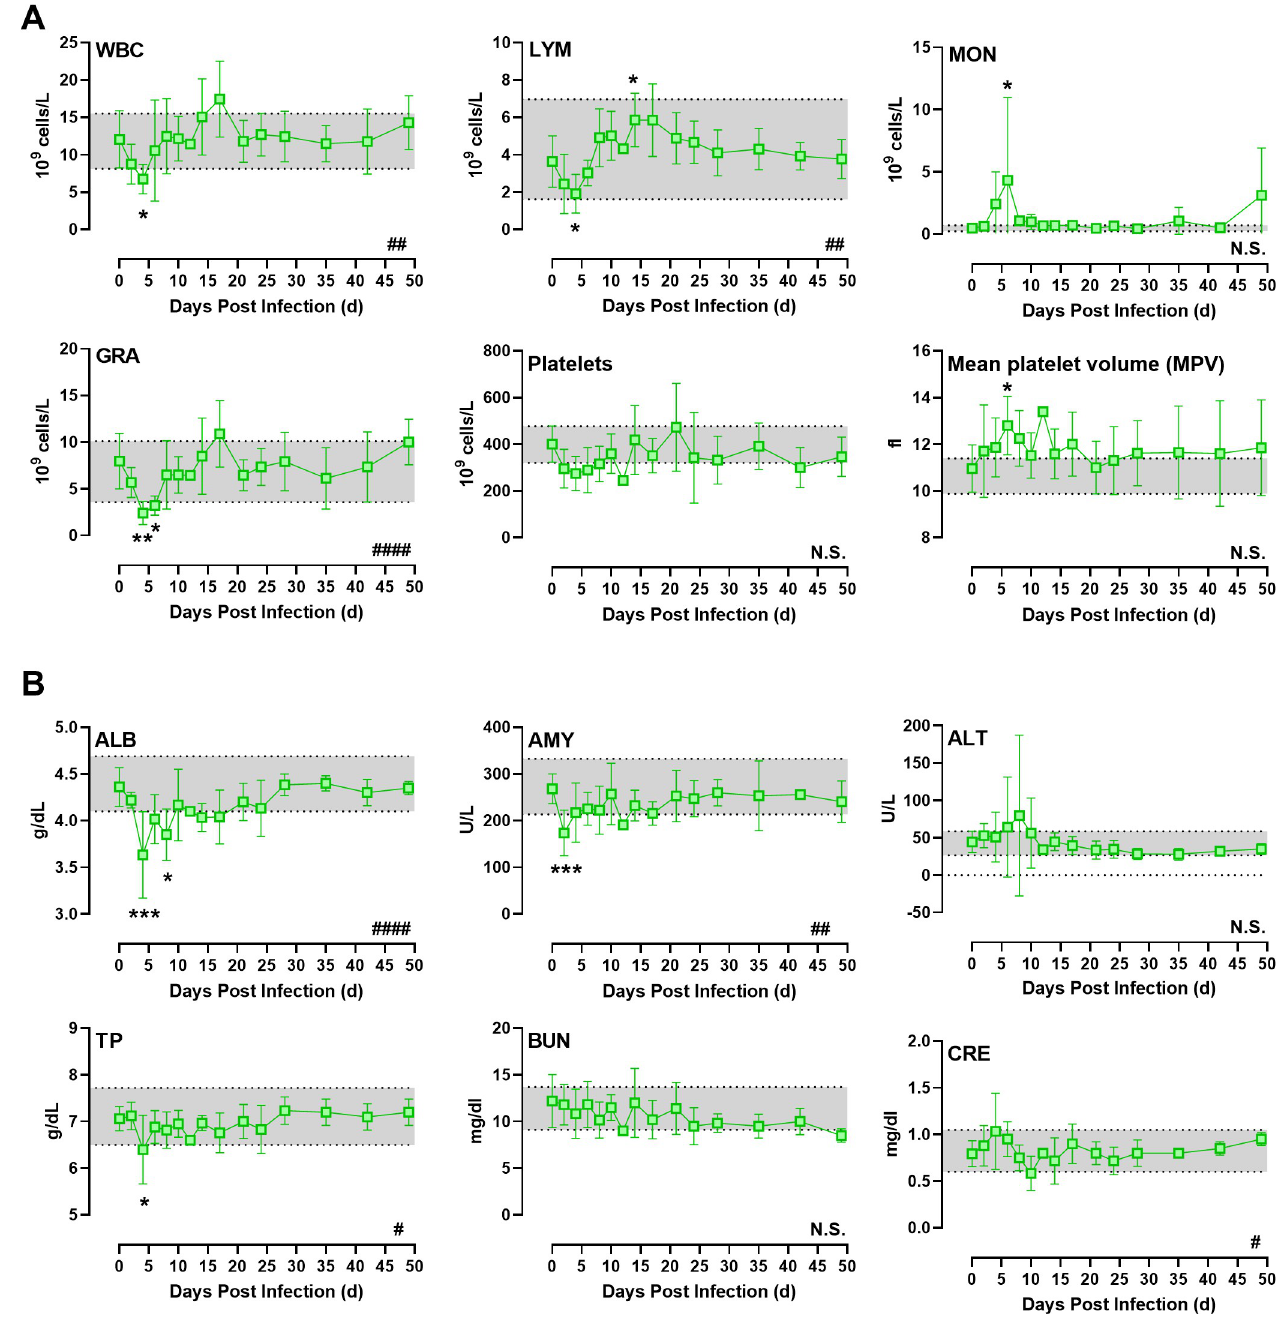
Fig 7. Alterations in CBC and blood chemistry parameters in VEEV-infected NHPs. Blood was sampled every 2 days and the average CBC results from VEEV-infected NHPs are shown (n = 6). Shaded area represents the range (min-max) of the mock-infected control animals. Data shown is up to 48 dpi. Hashtags in lower right corner of each graph indicate significance determined by 2-way ANOVA. Asterisks above or below data points indicate significance compared to 0 time point determined by multiple comparisons within ANOVA.